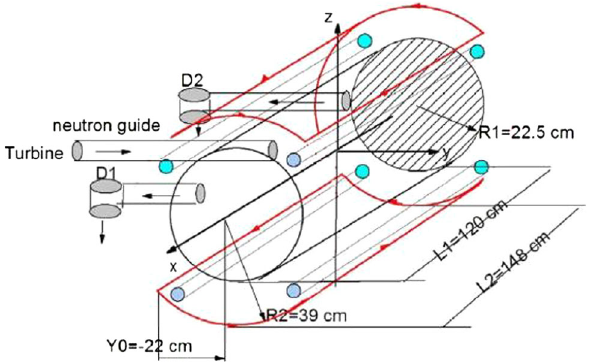
Fig. 1 Scheme of the UCN chamber used in the experiment. Positions of entrance valve from the neutron guide and exit valves to detectors D1 and D2 are shown. Electric circuits inducing magnetic field in the trap are shown by red contours